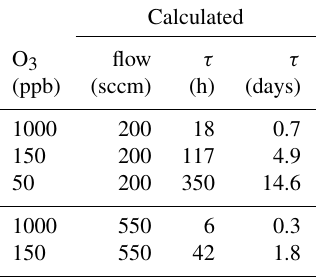
Table 4. Calculated scrubber lifetimes τ at exactly 200 and